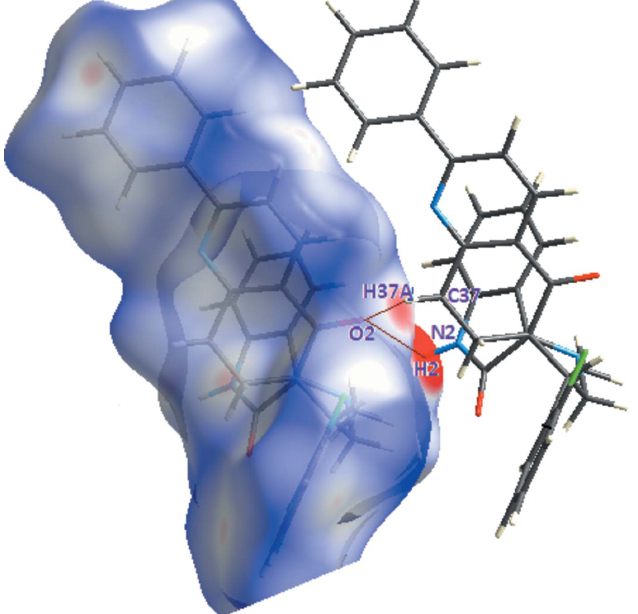
Figure 4 d norm mapped on the Hirshfeld surface for visualizing the contacts of the title compound. Dotted lines indicate hydrogen bonds.